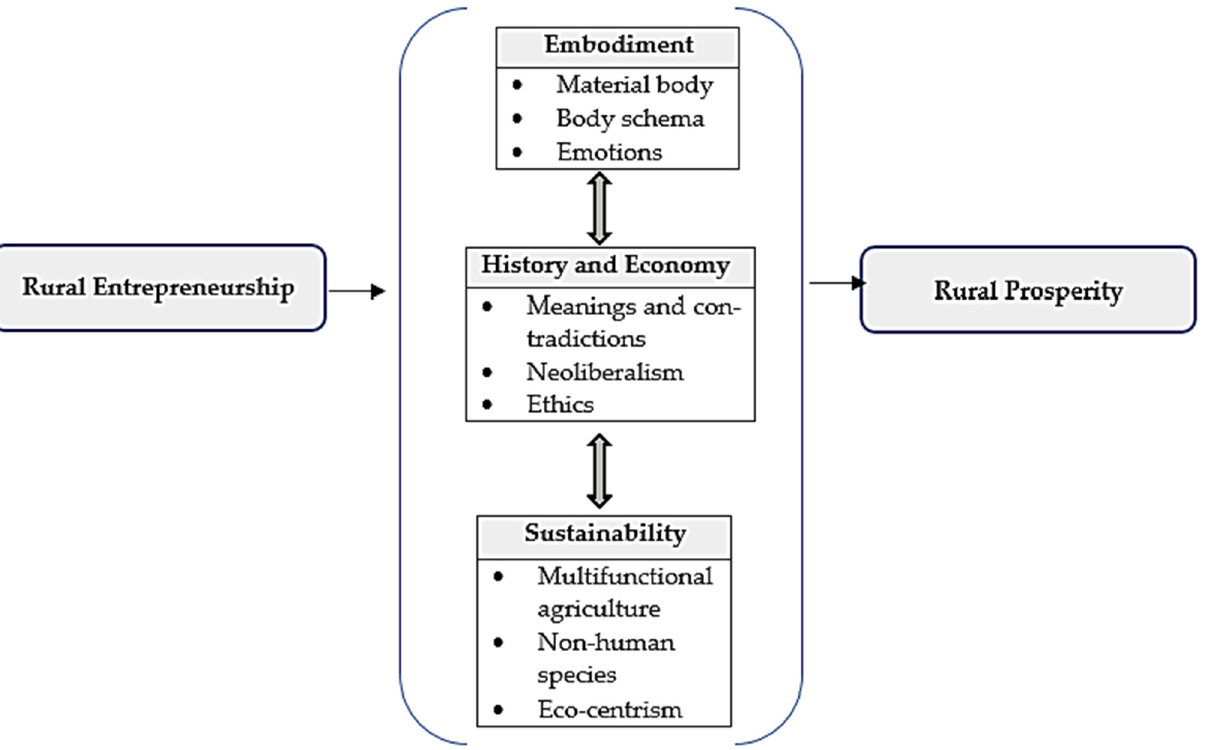
Figure 1. An integrated model for rural prosperity.